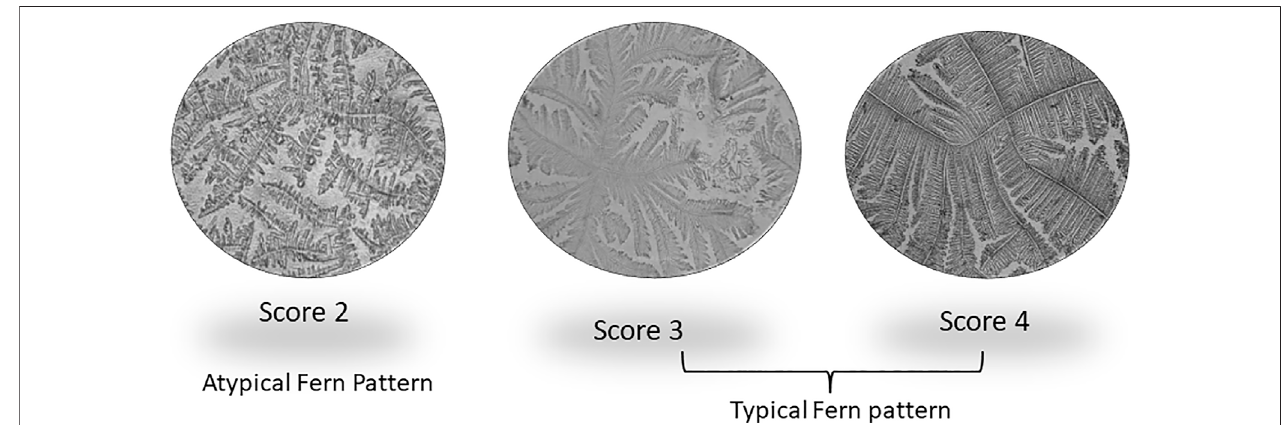
FIGURE 3 | Different crystallization/fern patterns of cervicovaginal mucus observed during estrus in buffaloes.